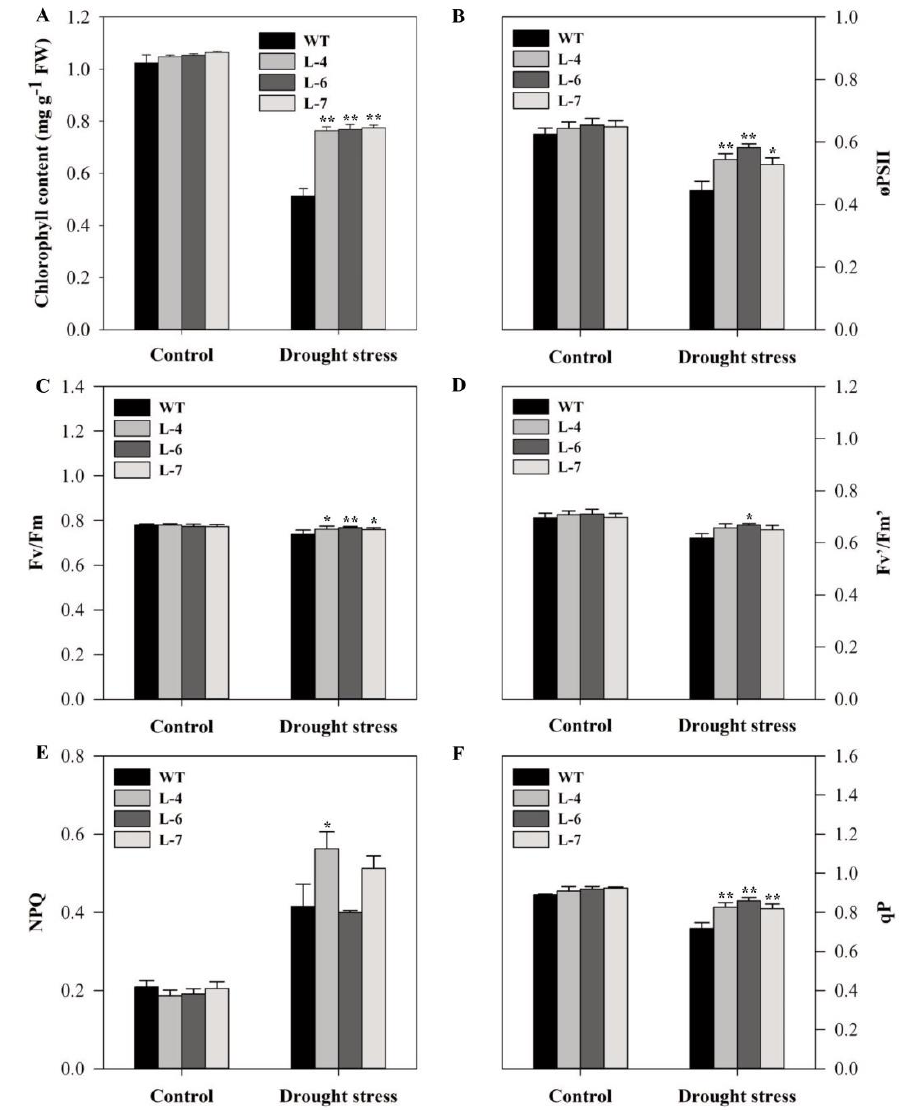
Figure 9. Overexpression of SlMAPK3 improved photosynthetic activity under drought stress. ( A ) chlorophyll content, ( B ) quantum efficiency of PSII photochemistry (øPSII), ( C ) the maximum photochemical efficiency of PSII ( Fv/Fm ), ( D ) the efficiency of energy capture by open PSII reaction centers ( Fv’/Fm’ ), ( E ) non-photochemical quenching (NPQ), and ( F ) photochemical quenching (qP). Two-months-old seedlings of WT and transgenic lines were subjected to drought stress by withholding water supply for 20 successive days and well-watered plants (watered every alternate day) served as control. Data represent mean ± SE of three biological replicates. **, * significant level differed at p < 0.01 and p < 0.05, respectively.